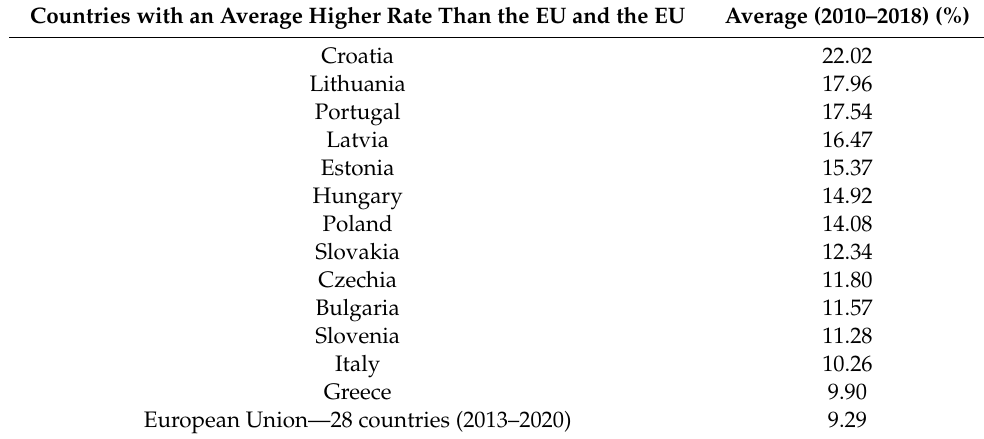
Table A3. Very bad and bad self-perceived health rate (Eurostat 2019c).